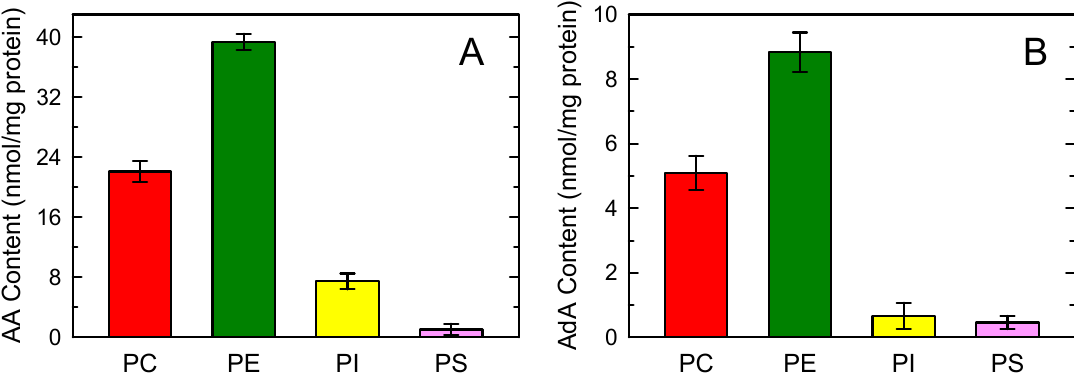
Figure 1. Distribution of AA and AdA between phospholipid classes. The various phospholipid classes were separated by thin-layer chromatography. The distribution of AA ( A ) and AdA ( B ) between choline glycerophospholipids (PC), ethanolamine glycerophospholipids (PE), phosphatidylinositol (PI), and phosphatidylserine (PS) was determined by gas chromatography / mass spectrometry (GC / MS) after converting the phospholipid-bound fatty acids into methyl esters. Results are shown as means ± standard error of the mean ( n = 3).